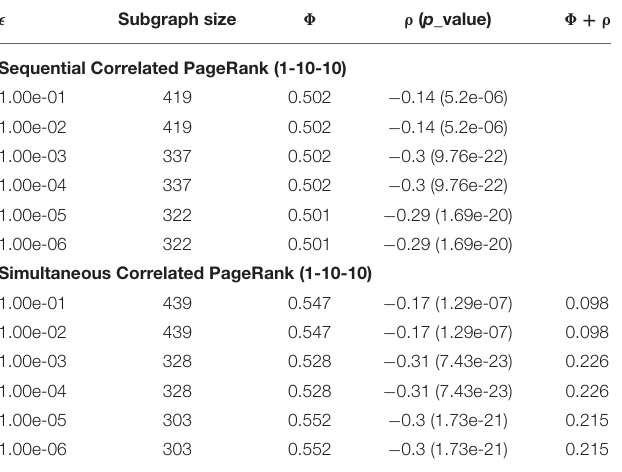
TABLE 1 | Tolerance effect on Correlated PageRank for 1-10-10 graph at α = 0.04 and seed = 2,137.